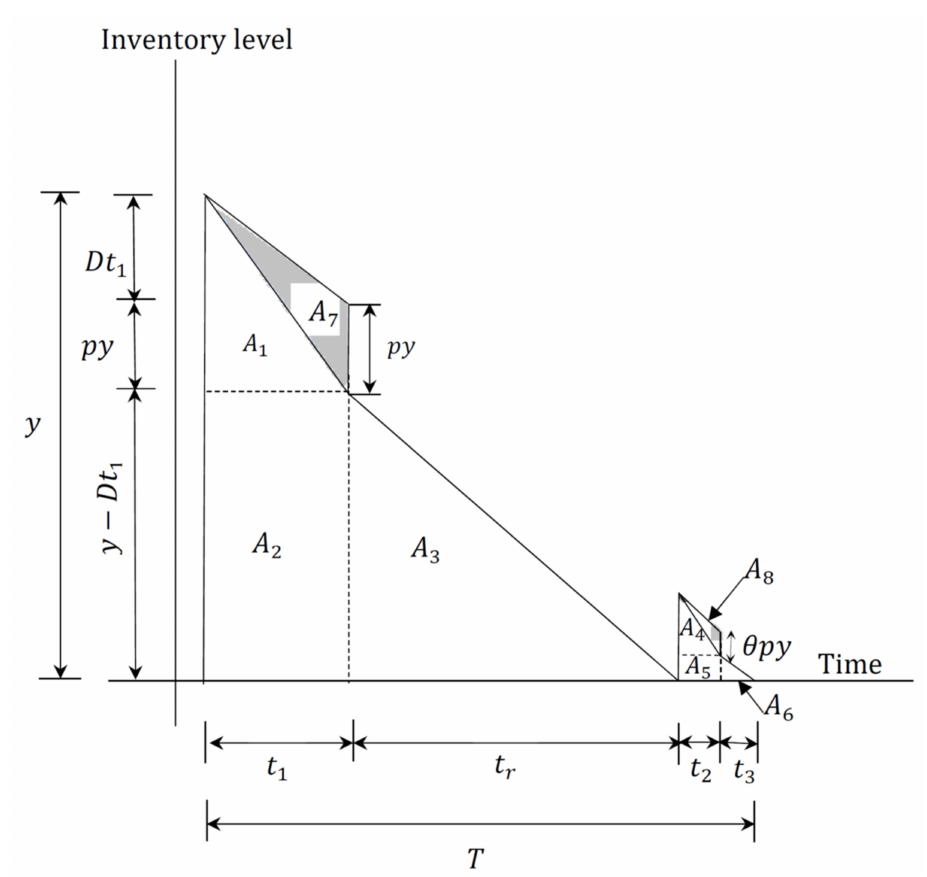
Figure 2. Inventory level through time for Case 2. The reworked lot enters when the inventory level is